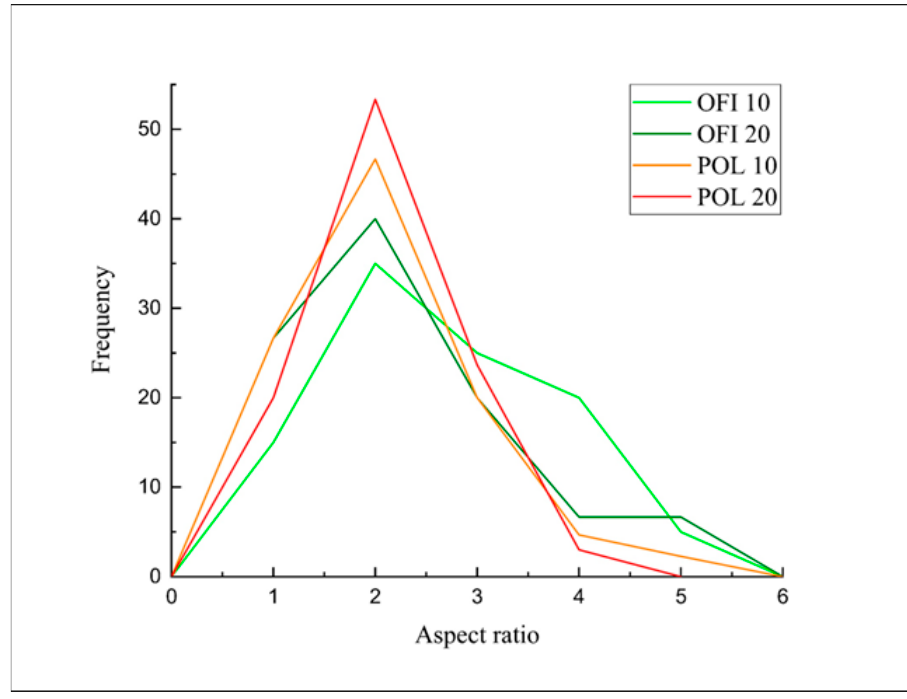
Figure 11. Size distribution of filler particles in OFI10, OFI20, POL10 and POL20 3D-printed samples.